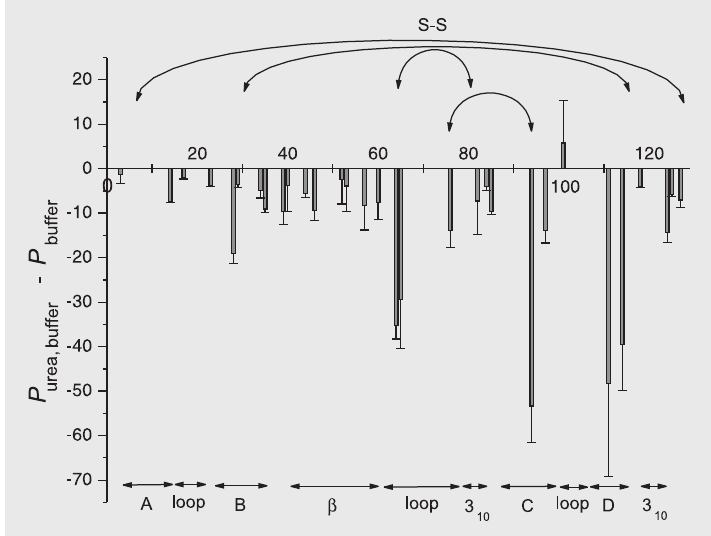
Figure 6. Differences in P -factors, ∆ P = P urea, buffer - P buffer , upon pressure-assisted cold denaturation of hen egg white lysozyme in the presence and absence of 2 M urea as a function of residue number. Upon addition of 2 M urea, the P -factors obtained decreased drastically. For other explanations, see legend to Figure